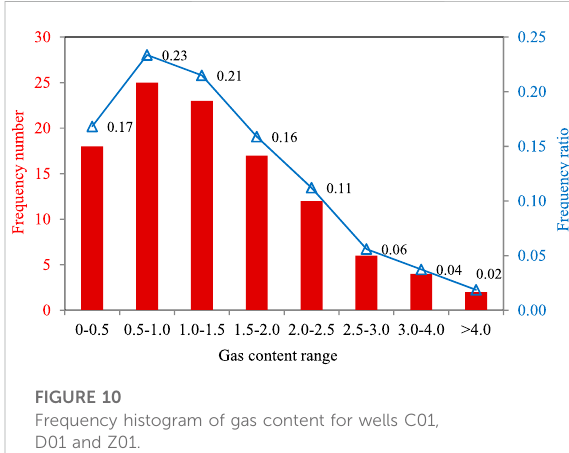
FIGURE 10 Frequency histogram of gas content for wells C01, D01 and Z01.